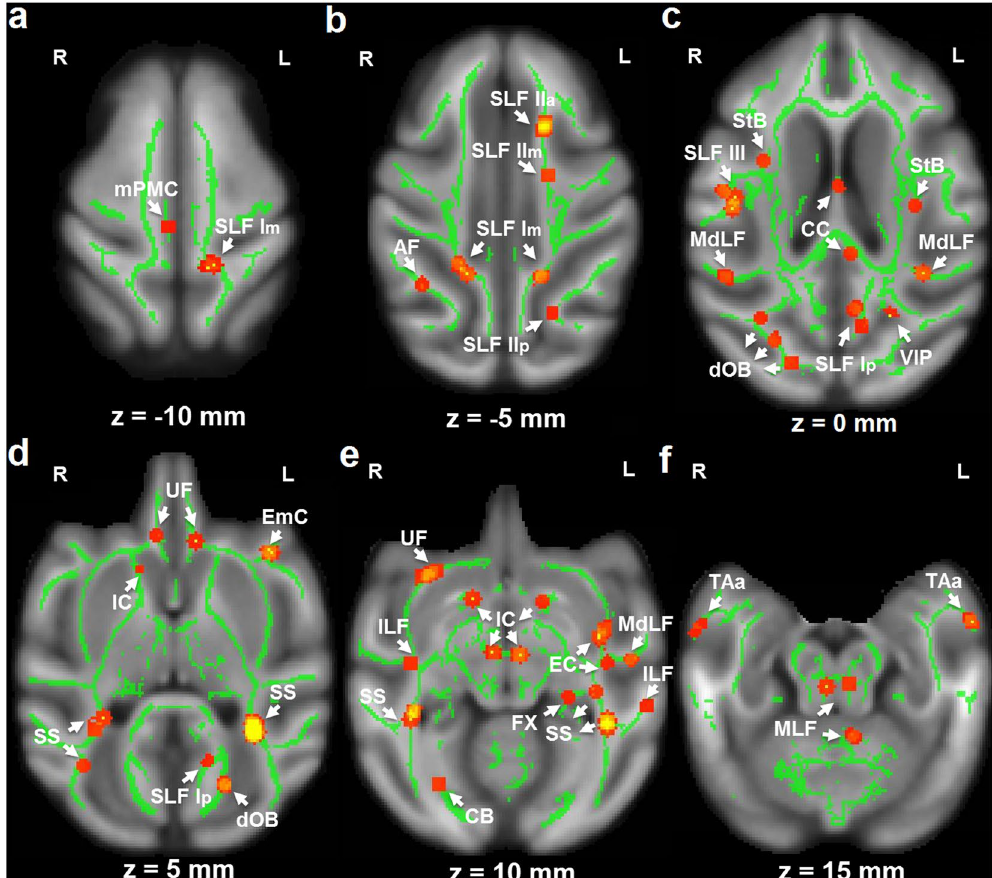
Figure 1. TBSS analysis of the whole brain through the horizontal direction (z). Areas with red-yellow color (scale: from low to high) indicate significant group difference for the ages with maximum FA (p < 0.05, corrected with FDR). To facilitate visualization, voxels showing significant difference were thickened using the “tbss_fill” script implemented in the FSL software. In the following ROI-based analysis, DTI-derived measures within the areas were averaged from the corresponding skeletonized map (e.g., FA, in green color). L, R: left or right